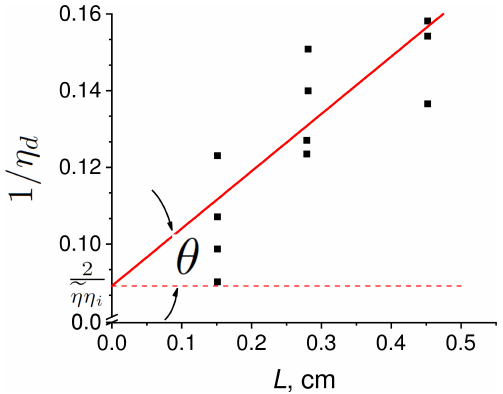
Figure 4. The dependence of the inverse slope efficiency on the cavity length. The black squares show experimental data. The red line is the data line